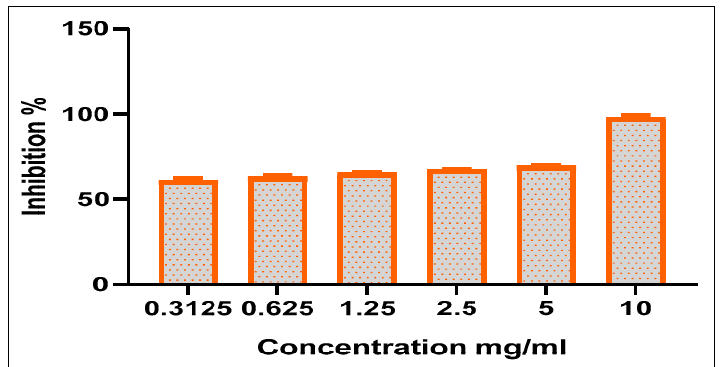
Figure 3. Beta-carotene bleaching percentage of hexane extract of C. colocynthis seed.